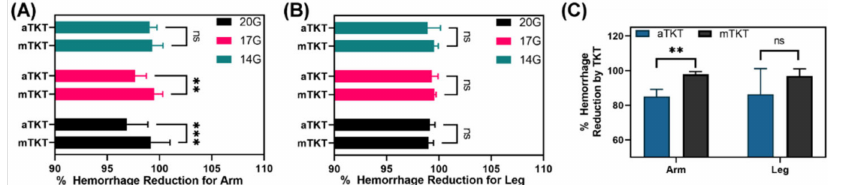
Figure 4. Performance of the aTKT to stop hemorrhage compared to mTKT. Percent hemorrhage reduction 30 s after TKT application for the aTKT and mTKT using the synthetic ( A ) arm or ( B ) leg setup. Average results are shown for 80, 120, 160, and 200 bpm for each of three hemorrhage rates as shown ( n = 12). Values on the x -axis begin at 90% instead of 0% to better highlight differences. Significant differences between hemorrhage rates were determined by two-way ANOVA, post- hoc Sidak’s. ( C ) Percentage hemorrhage reduction five minutes after TKT application for a 14G hemorrhage at 160 bpm ( n = 3). Significant differences between hemorrhage rates were determined by unpaired t -test (**, p < 0.01; ***, p < 0.005; ns = not significant). Error bars denote standard